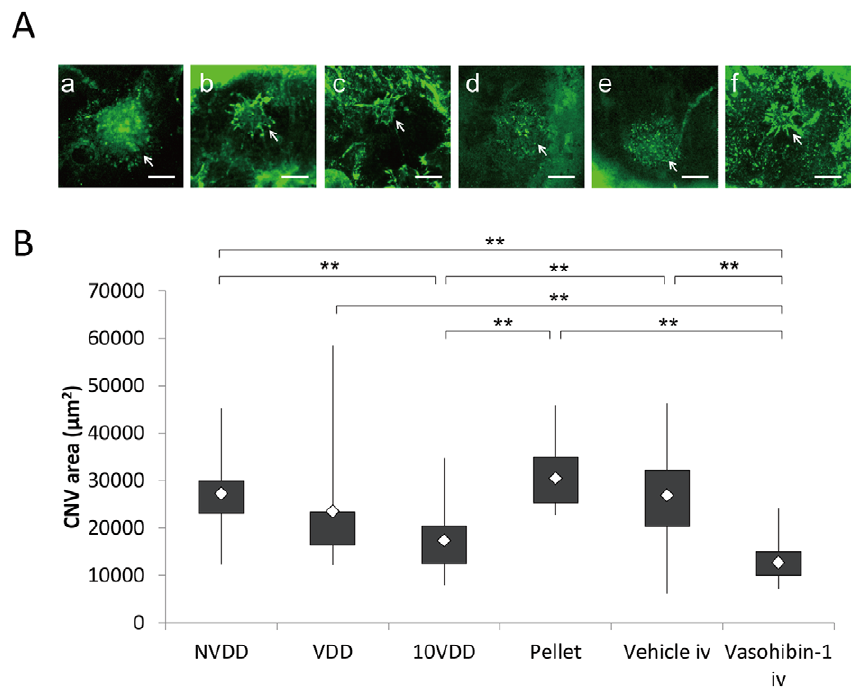
Figure 6. Flat-mount examination of the CNV site. The areas of choroidal neovascularization with devices, pellets, and intravitreal injection of recombinant vasohibin-1 protein. (A) Representative choroidal flat-mount photographs of the groups treated with NVDD (a), VDD (b), 10VDD (c), vasohibin-1 pellet (Pellet) (d), intravitreal vehicle injection (Vehicle iv) (e), intravitreal vasohibin-1 injection (Vasohibin-1 iv) (f) eyes at 2 weeks after the CNV laser procedure. Mean values of actual areas are shown in the text. Bars: 200 m m. (B) Significantly smaller CNV areas were observed in the 10VDD group when compared to those of the NVDD (p=0.0004), Pellet (p=0.0011), and Vehicle iv groups (p=0.000015). Significantly smaller CNV areas were observed in eyes treated with Vasohibin-1 iv when compared to those treated with NVDD (p=0.000006), VDD (p=0.0036), Pellet (p=0.000023), or Vehicle iv (p=0.000001). NVDD: non-vasohibin-1 (vehicle) delivery device, VDD: 1 m M vasohibin-1 delivery device, 10VDD: 10 m M vasohibin-1 delivery device, Pellet: vasohibin-1 pelletized at the same concentration of 10VDD (without reservoir and